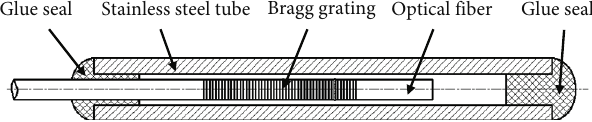
Figure 1: Encapsulated FBG for temperature